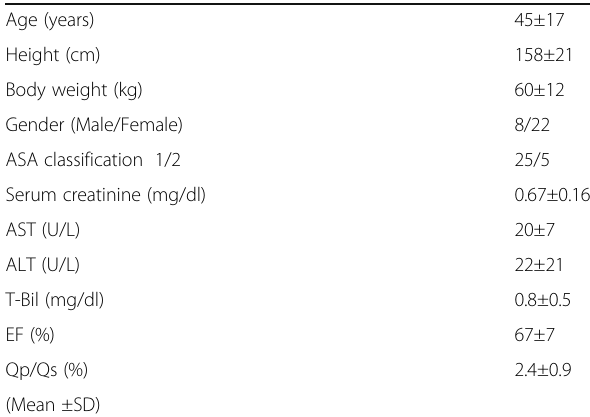
Table 1 Patients ’